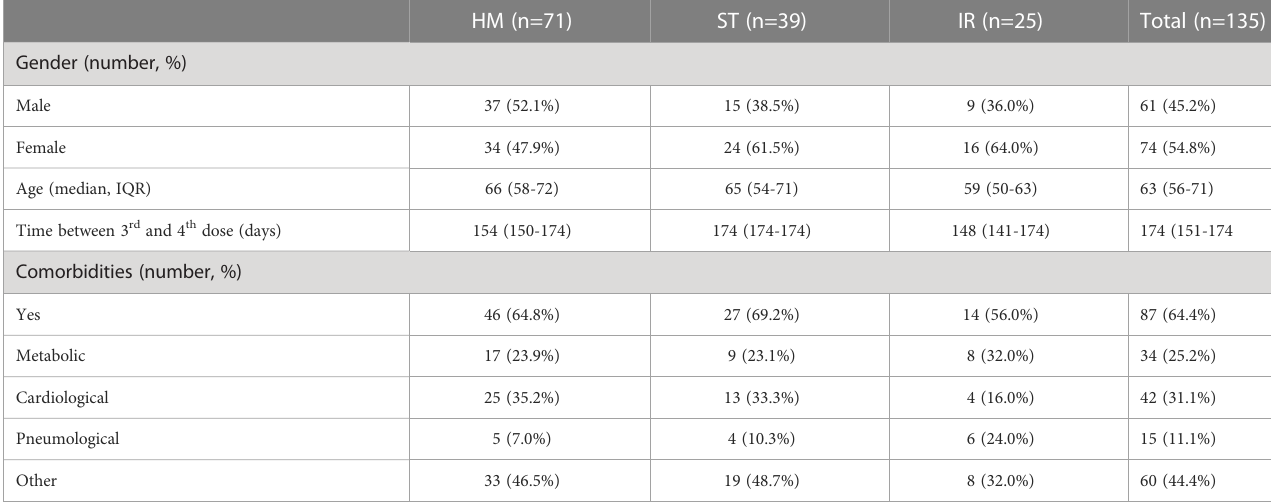
TABLE 1 Patients ’ characteristics